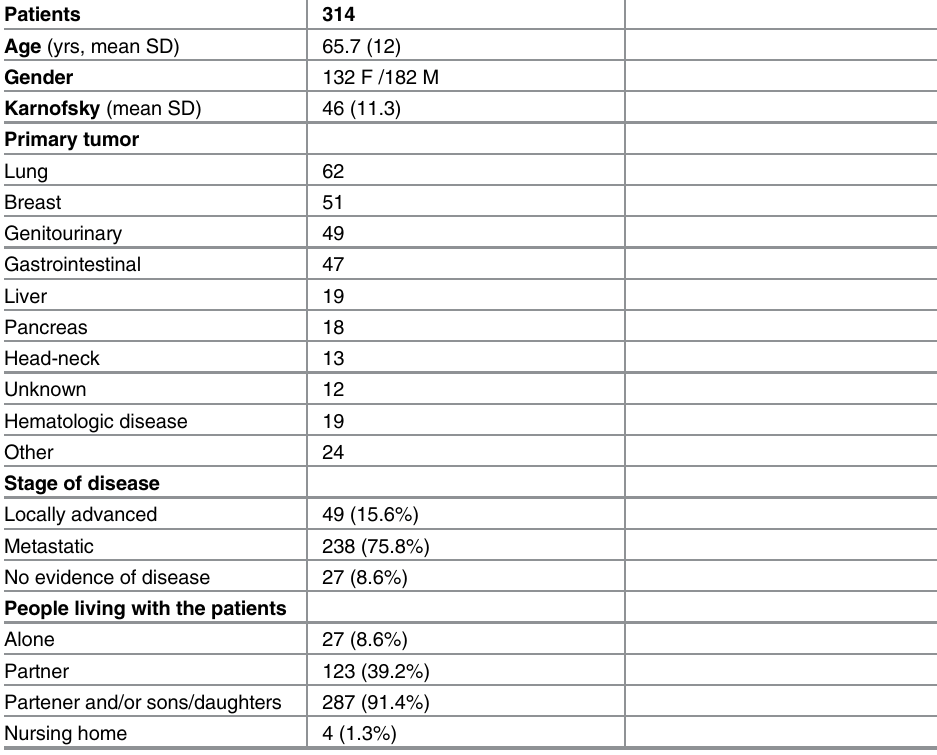
Table 1. Characteristics of